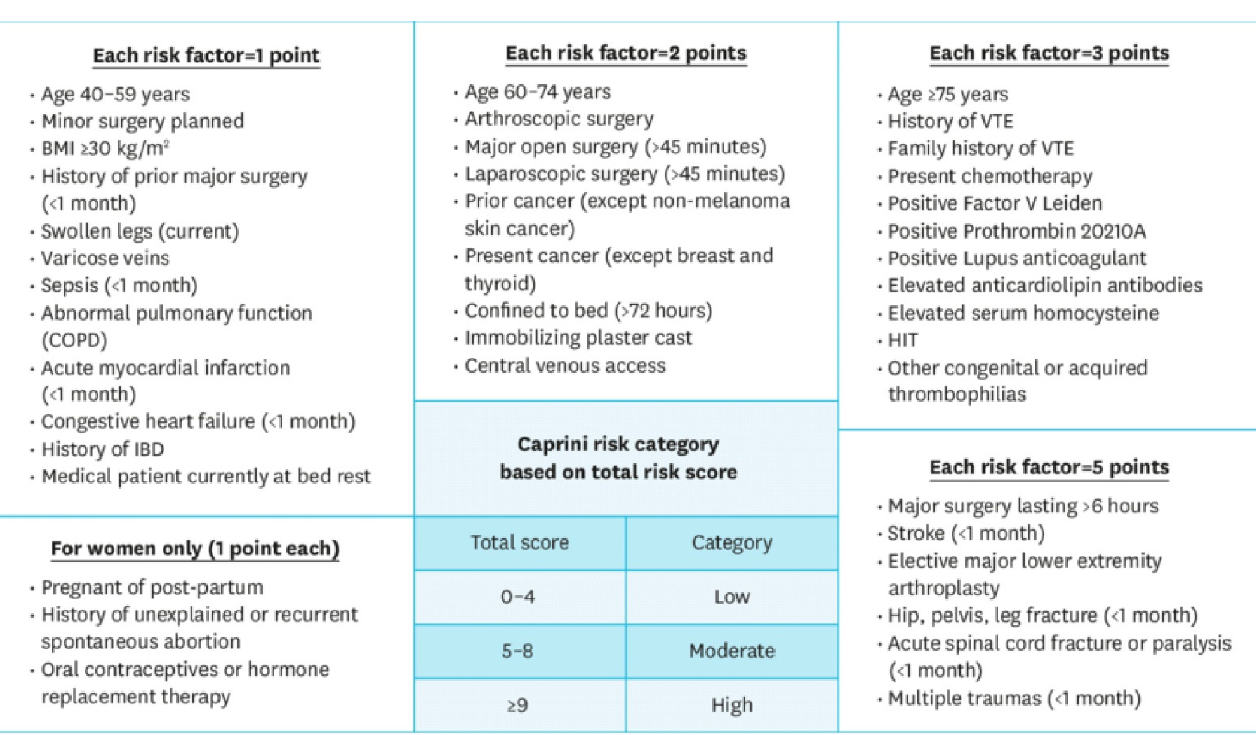
Table 1. The Khorana score for estimating venous thromboembolism risk in patients with cancer. Risk Factor Points Site of primary tumour